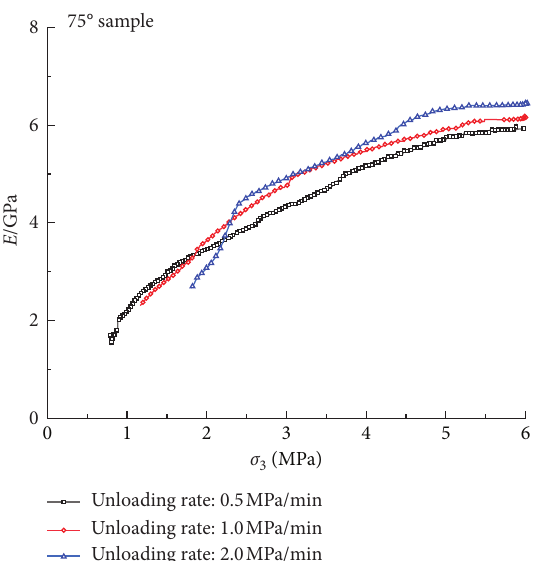
Figure 8: Relation curves of deformation modulus and confining pressure.